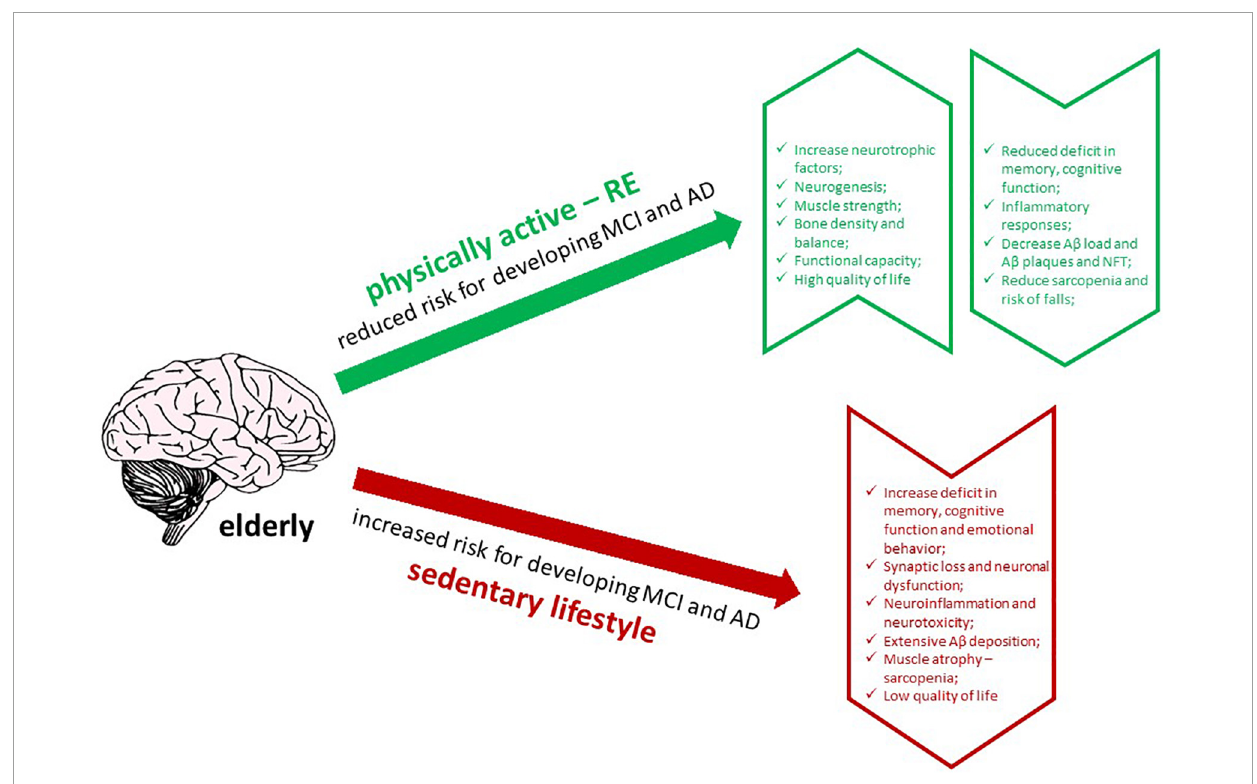
FIGURE1 Graphic abstract of the effects of RE in AD brain (created with